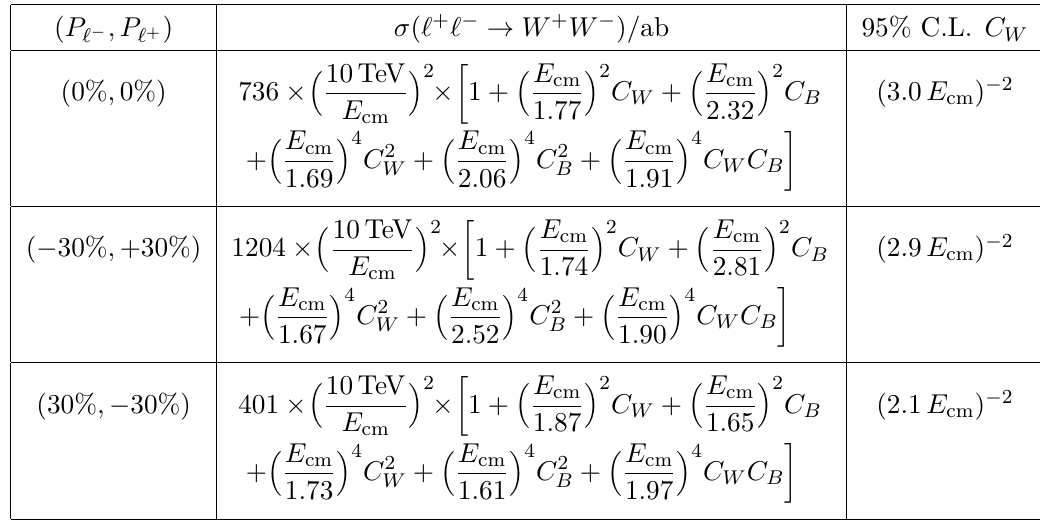
Table 3 . Fiducial ‘ + ‘ − → W + W − cross-section in ab, as a function of the collider energy E cm and the Wilson coefficients C W , C B , for different beam polarizations. The 95% C.L.